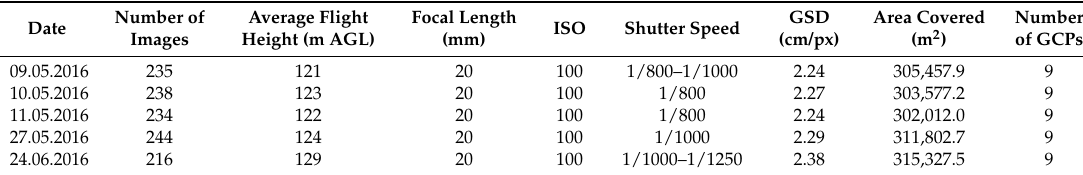
Figure 3. UAS-based orthophotos. Table 1. Key flight mission data.